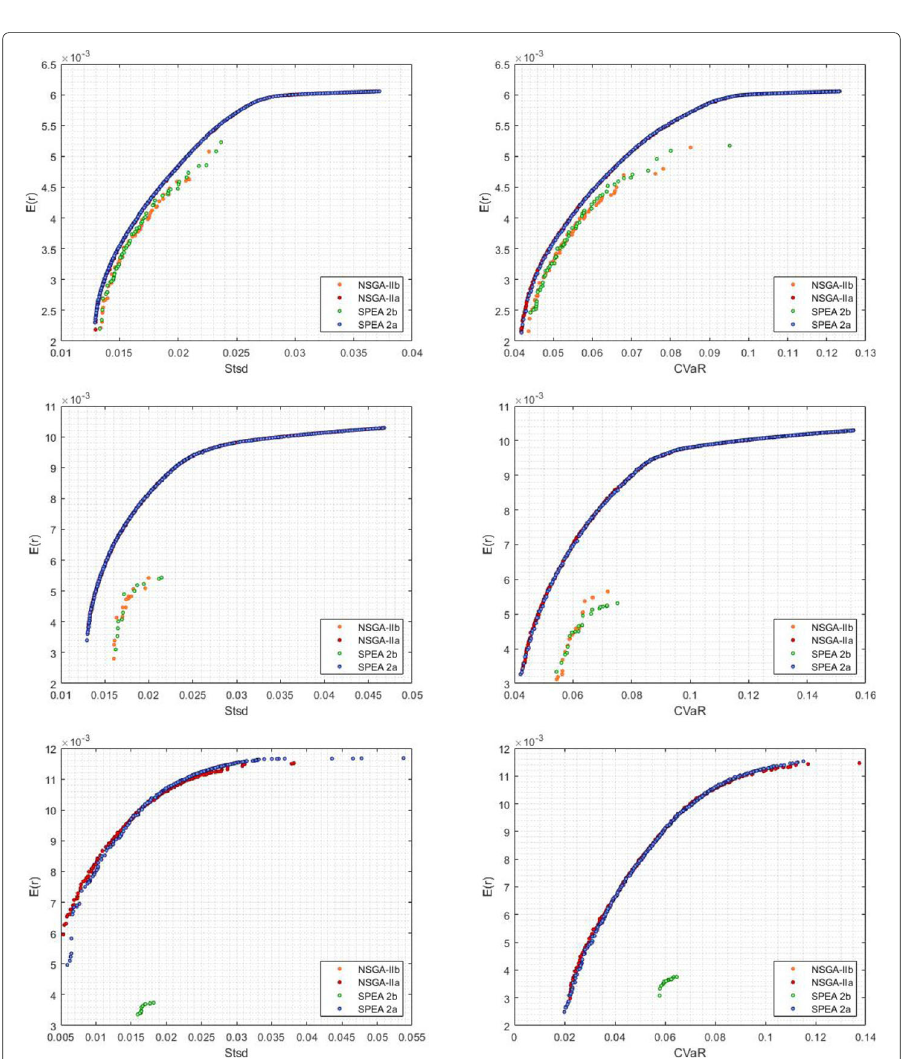
Fig. 1 Approximated Pareto fronts for the Mean-semi-variance (on the left) and Mean-CVaR (on the right) portfolio optimization problems corresponding to the simulations with the highest HV values obtained by NSGA-IIb, NSGA-IIa, SPEA 2b and SPEA 2a for the datasets DowJones (charts at the top), NASDAQ100 (charts in the middle) and NASDAQComposite (charts